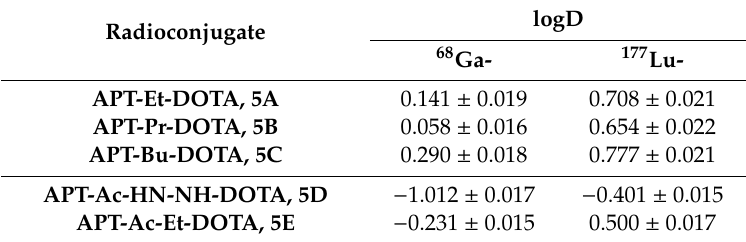
Table3. LogDvaluesofhumanserumstableradioconjugatesdeterminedin n -octanol / PBSbu ff ersystem.